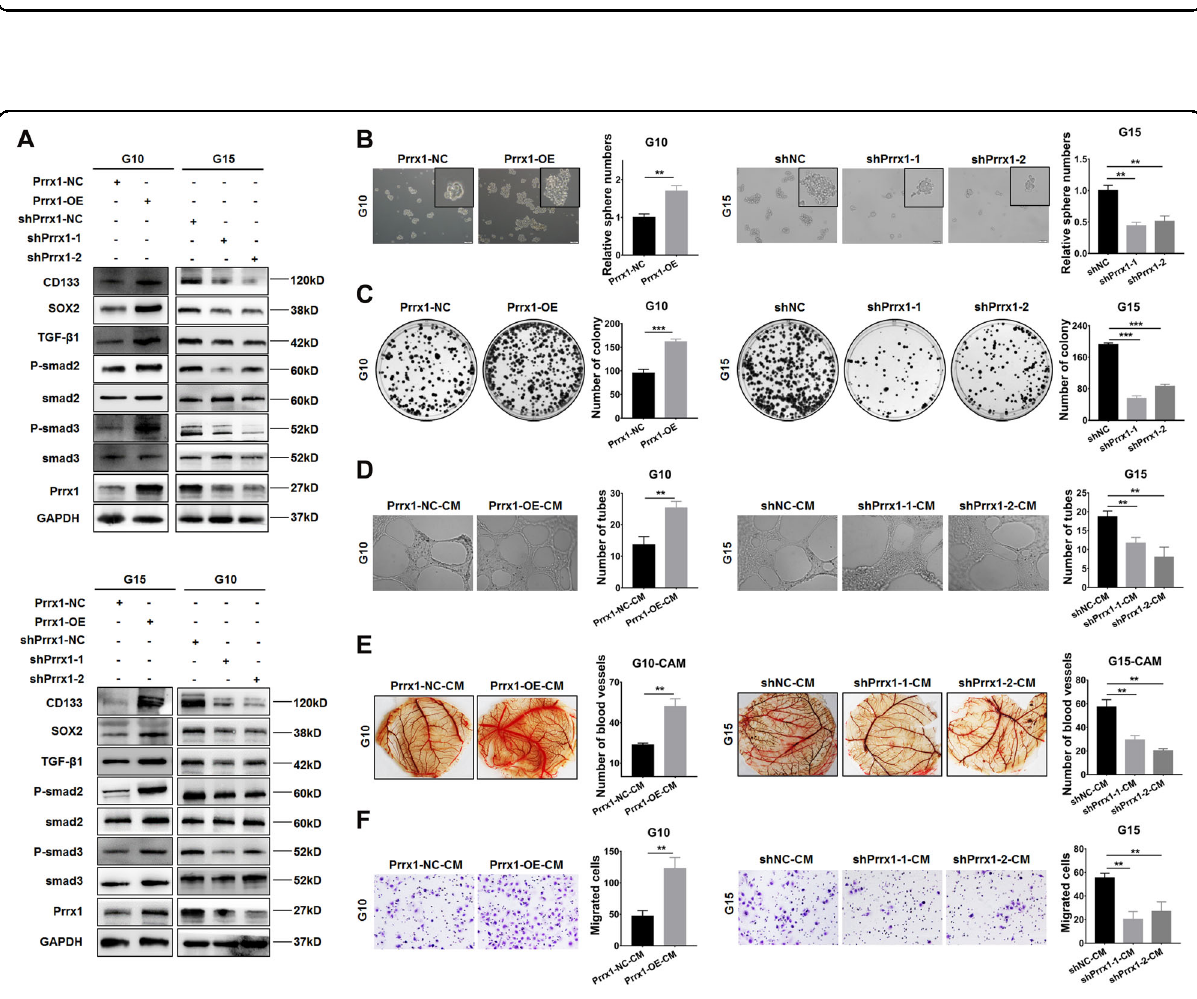
Fig. 5 Prrx1 promotes stemness maintenance and angiogenesis, as well as activates TGF- β /smad pathway in GSCs. A Western blot analysis of the expression of GSC markers and TGF- β /smad pathway markers in Prrx1 overexpression and knockdown primary GSCs. B , C Sphere formation assay ( B ) and colony formation assay ( C ) of GSCs to explore the effect of Prrx1 on stemness maintenance. Scale bar represents 50 μ m. D Representative capillary tubule structures were shown for HUVECs treated with culture medium collected from the indicated primary GSCs. Scale bar represents 50 μ m. E Blood vessels formed in representative images of the CAM assay after CM treatment. F Transwell assay was performed in HUVECs to detect the effect of CM treatment on cell migration. Scale bar represents 50 μ m. * P < 0.05, ** P < 0.01.